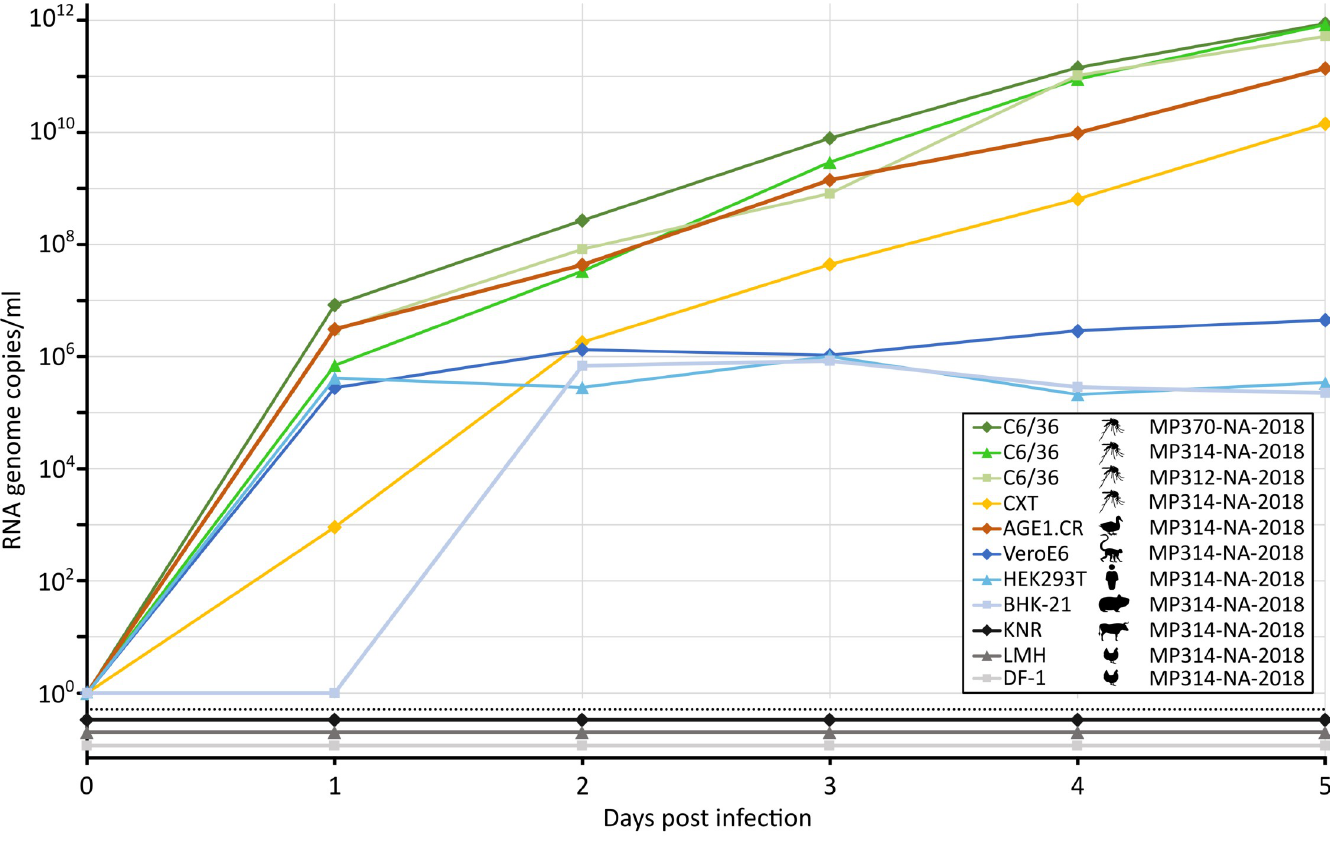
Fig 6. BAGV growth in vertebrate and insect cell lines. The mosquito cell line C6/36 (derived from Aedes Stegomyia albopictus ) was infected with the three BAGV strains MP312-NA-2018, MP314-NA-2018, and MP370-NA-2018 in duplicates at an MOI of 0.01. Mammalian cell lines BHK-21 (hamster), HEK293T (human), VeroE6 (monkey) and KNR (cattle) were infected in duplicates with BAGV strain MP314-NA-2018 at an MOI of 0.1. Avian cell lines AGE1.CR (duck), LMH (chicken) and DF1 (chicken) and the insect cell line CXT (derived from Culex tarsalis ) were infected in duplicates with BAGV strain MP314-NA-2018 at an MOI of 0.01. A sample of cell culture supernatant was taken every 24 hours for five consecutive days and viral copy numbers were determined by RT-qPCR.